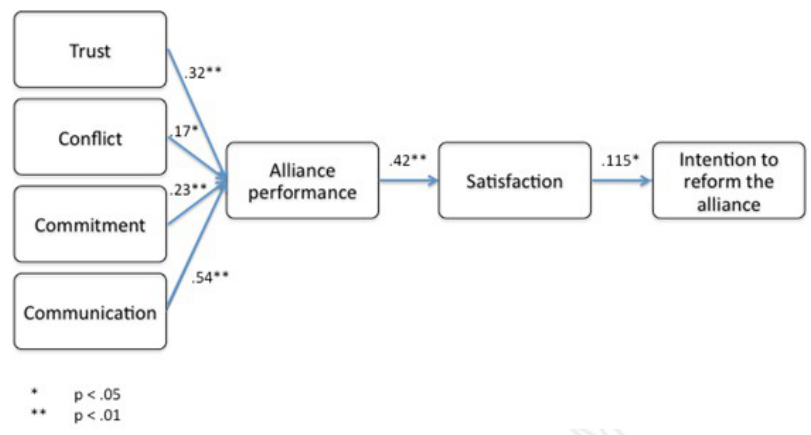
Figure 2. Effect of individual relationship on alliance performance, satisfaction and reformation of the